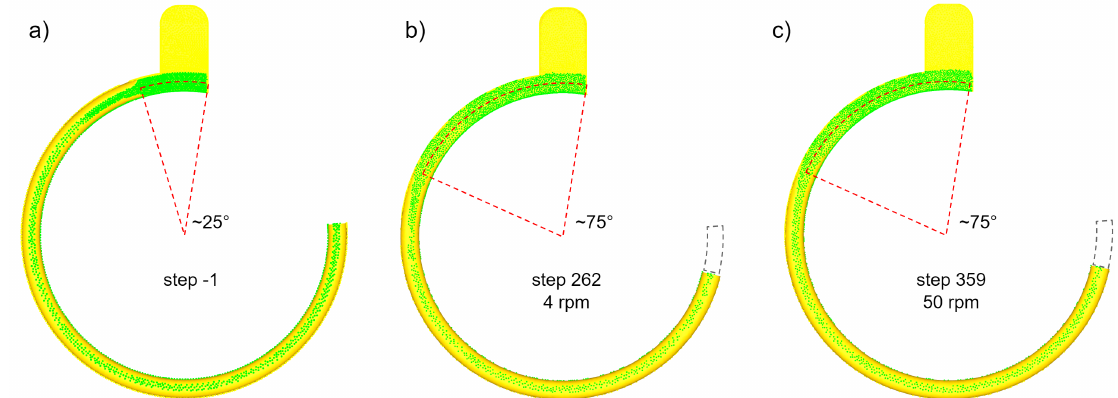
Figure 8. The feedstock material and the nodal contact points at steady-state for different rotational speeds. ( a ) the initial extrusion grip length in the extruder; ( b ) extrusion grip length at 4 RPM; ( c ) extrusion grip length at 50 RPM is similar to that of 4 RPM.